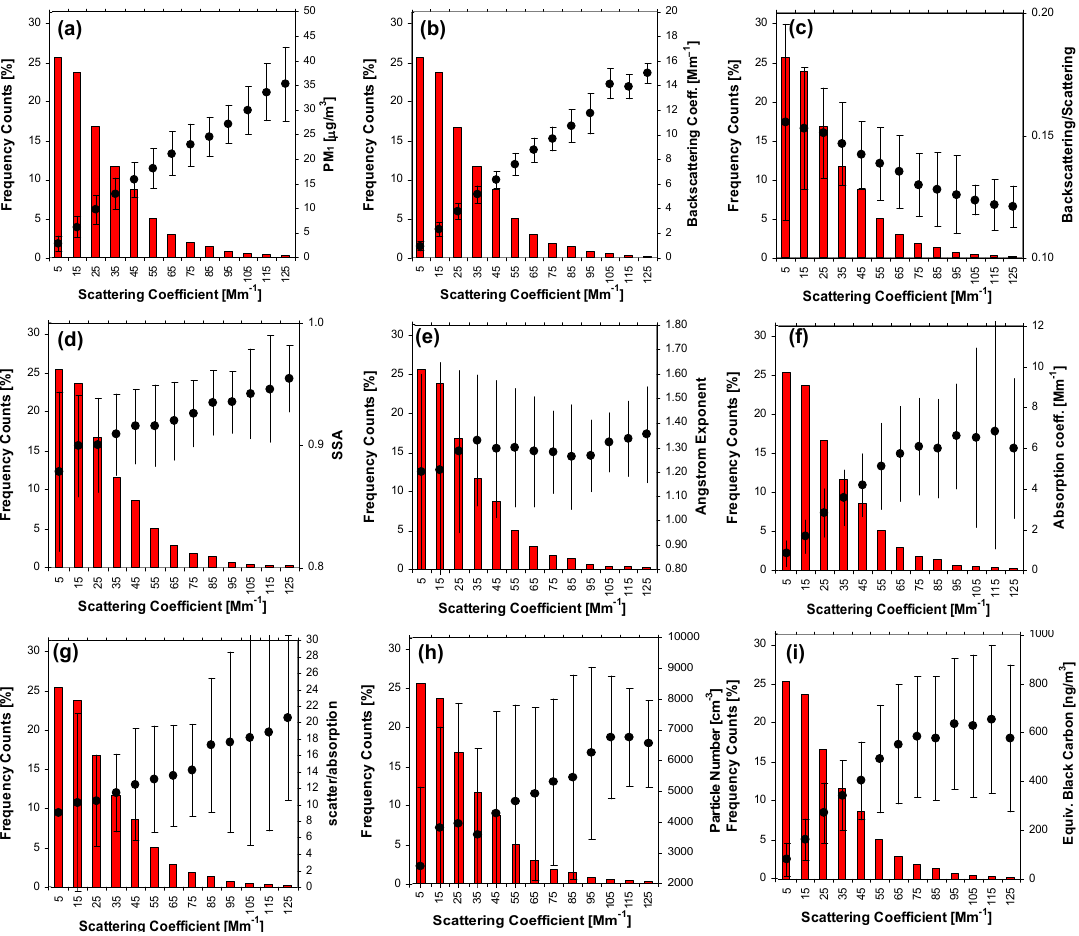
Fig. 7. Correlation between the frequency distribution of aerosol scattering coefficients at 635nm and (a) PM 1 concentration, (b) backscatter- ing coefficient, (c) backscattering-to-scattering (B/S) ratio, (d) Single Scattering Albedo, (e) ˚Angstr¨om exponent, (f) absorption coefficient, (g) scattering-to-absorption ratio, (h) particle number concentration, and (i) equivalent black carbon